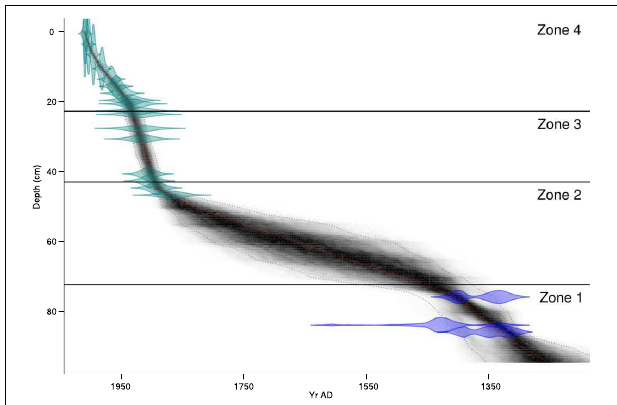
FIGURE 2 | CUNS2 core chronology.